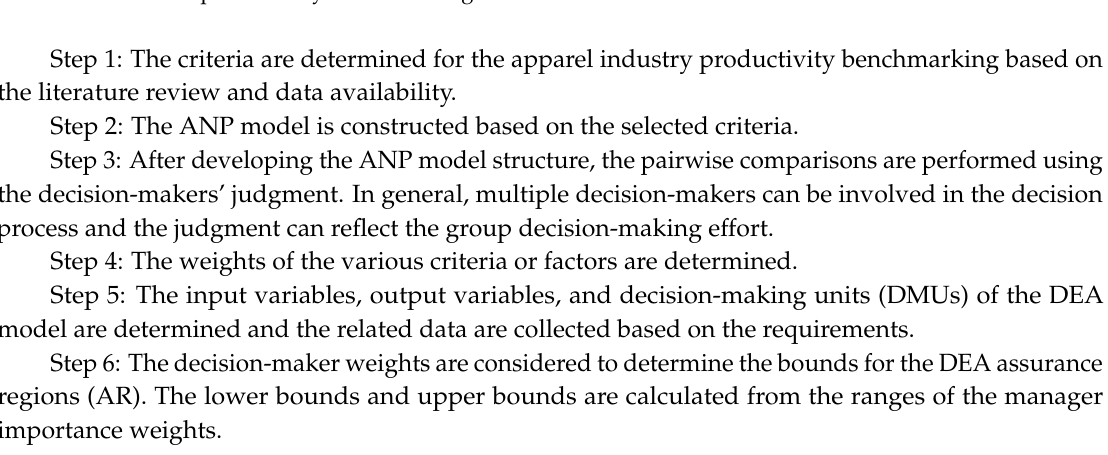
Figure 1. Proposed analytic network process and data envelopment analysis (ANP-DEA)-based framework for productivity benchmarking.